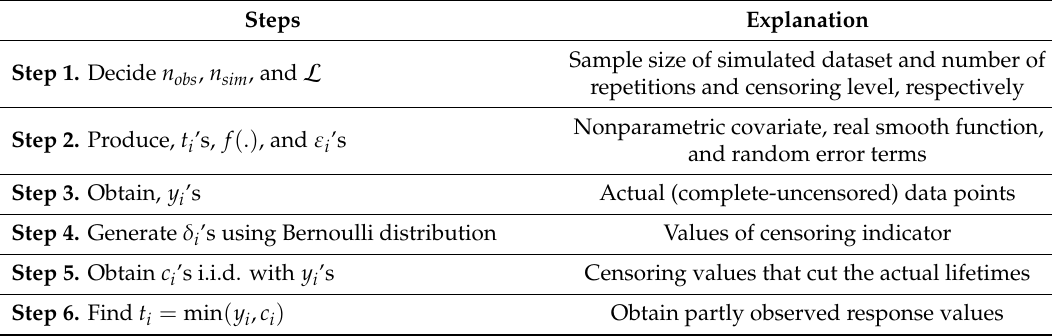
Table 1. Data generation procedure with